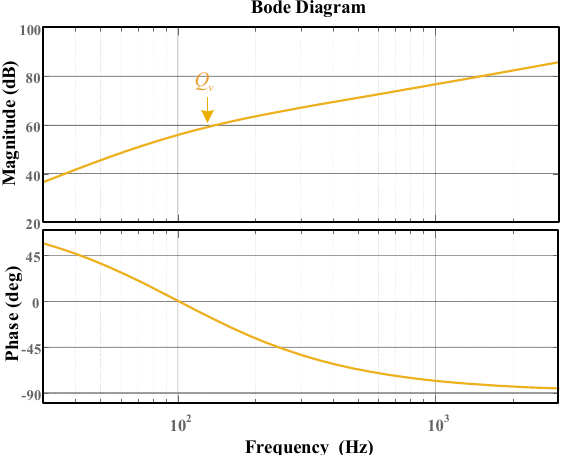
Figure 9. Bode diagram of Q v . Figure 10 shows small-signal control block diagram of LCL-TFSCI after impedance reshaping. The proposed method is equivalent to introducing the additional impedance Q v into the inverter output impedance model. Figure 11 shows equivalent model of interactive system between LCL-TFSCI and grid after impedance reshaping.